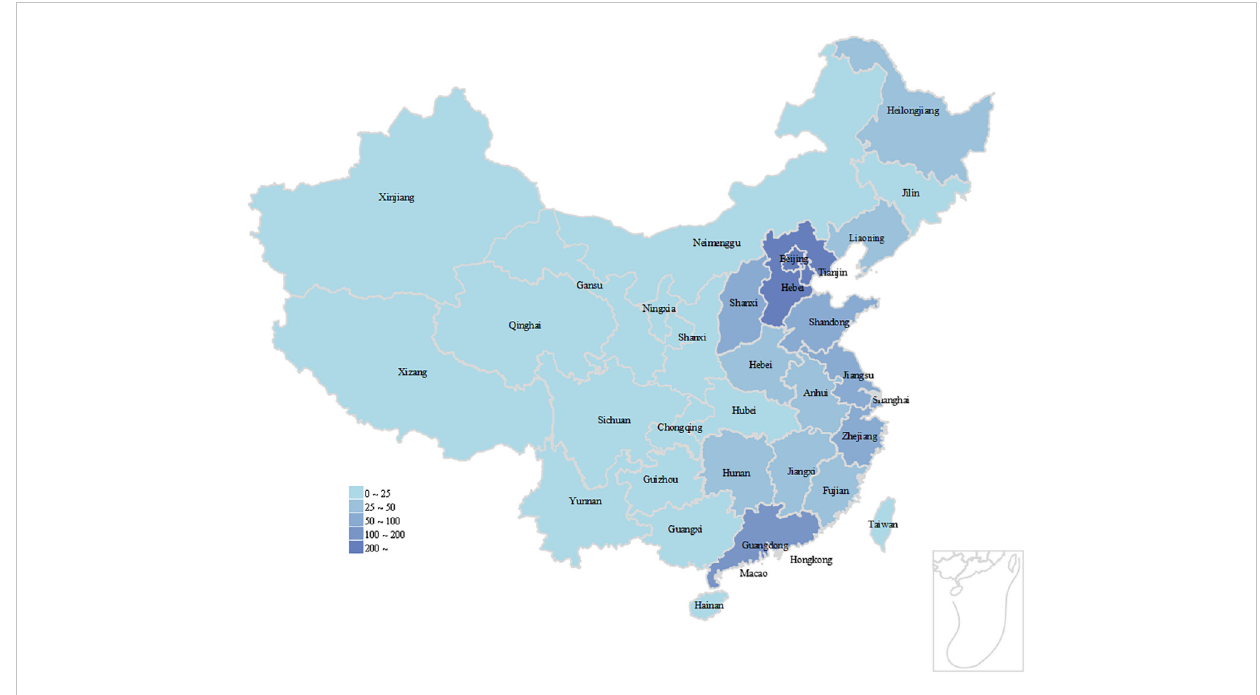
FIGURE 2 Distribution of participants ’ region of residence.